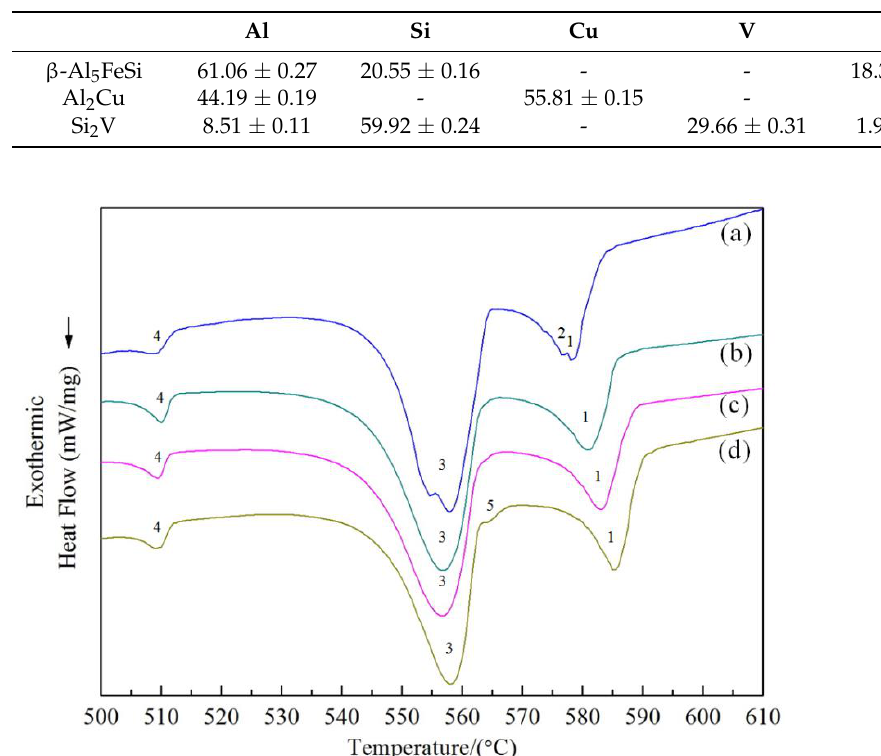
Figure 5. Differential scanning calorimetry (DSC) curves of the alloys with different vanadium contents during solidification process (1, 2, 3, 4, 5 are serial numbers of the exothermic peaks): ( a ) A1 alloy; ( b ) A2 alloy; ( c ) A3 alloy; ( d ) A4 alloy. Table 3. Average size and volume fraction of compounds in the alloys with different vanadium